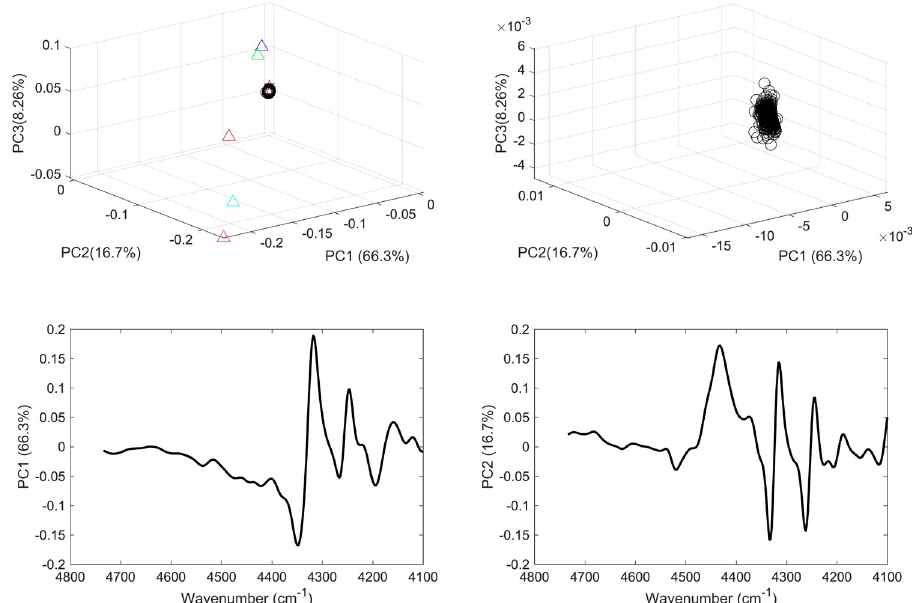
Fig 5. (a) PCA scores plot of COVID-19 vaccine (black circles), mRNA (red star), purified RNA (green and blue stars), normal saline solution (red and green squares) and excipients 1–5 (blue, red, green, cyan and magenta triangles); (b) PCA scores plot of COVID 19 vaccines; (c) PCA loading plot of vaccines and constituents and (d) PCA loading plot of vaccines. The models were applied considering the wavenumber range of 4100–4736 cm -1